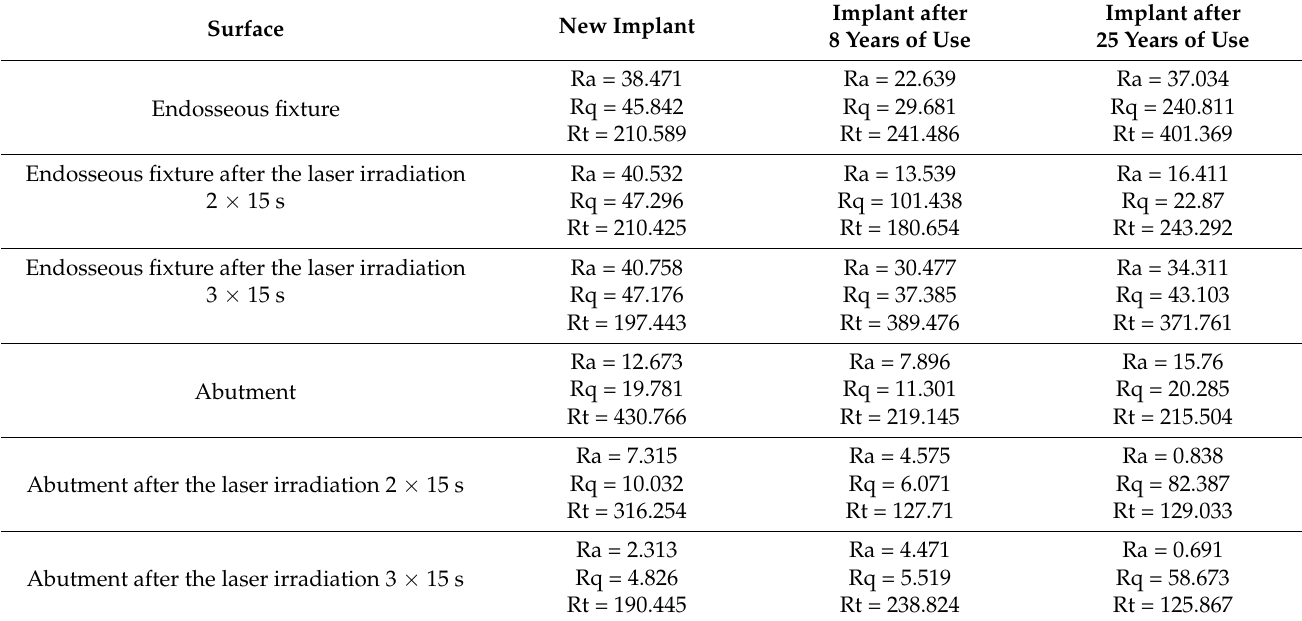
Table 5. Roughness parameters (the arithmetic mean—Ra, the square mean—Rq, and the height of the largest profile cavity—Rt) determined by optical profilometry for the implant: new, and those removed after 8 and 25 years before and after the 25 W/15.000 Hz laser irradiation/10 µ s, average = 3.84 W in the doses of 2 × 15 s and 3 × 15